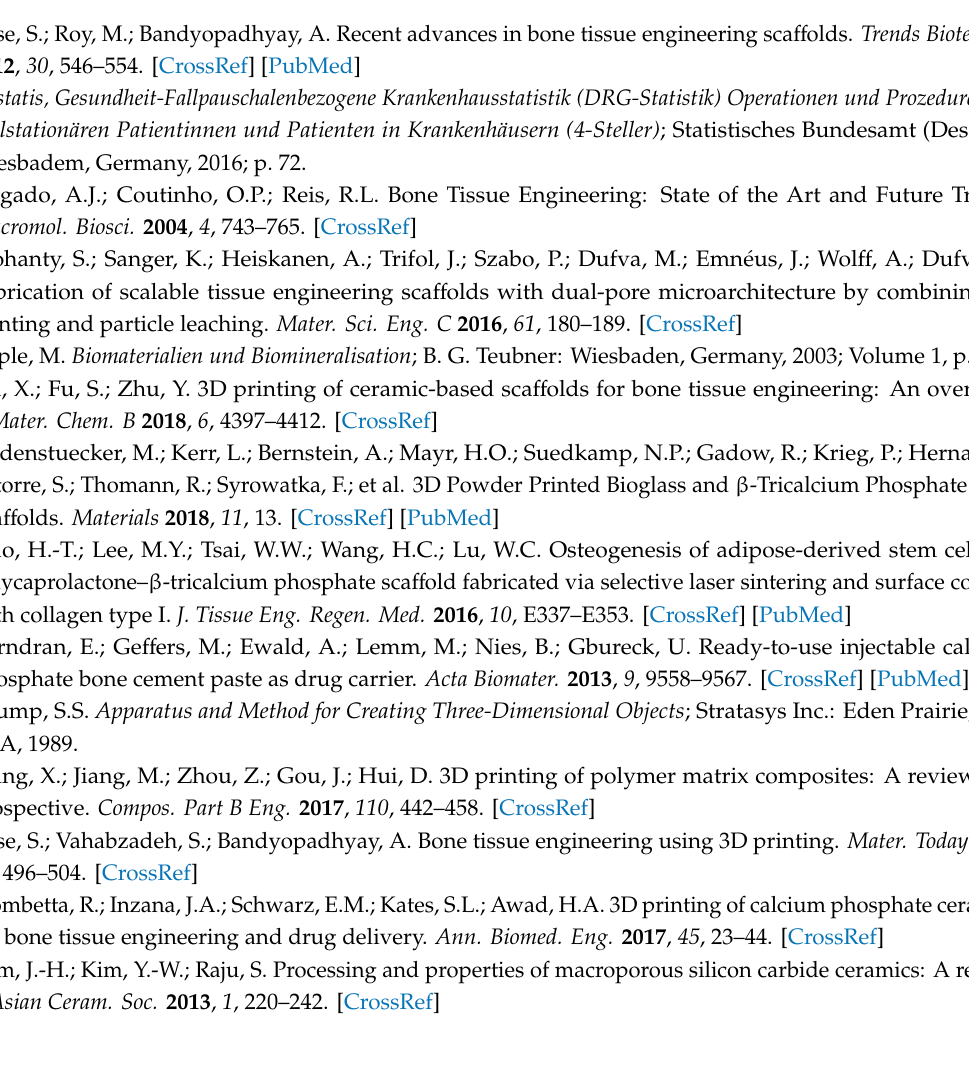
Figure S1. SBF treated samples, left = ESEM images of all three sca ff old sizes (a: 500 µ m; b:750 µ m; c: 1000 µ m) with HFW of 93.3 µ m; right = magnification of selected section with HFW of 11.7 µ m (d: 500 µ m; e: 750 µ m; f: 1000 µ m ), Figure S2: Living / Dead Cells inside the ceramics, vertical cut of 750 µ m sca ff old after three days (a: Living; d: Dead), seven days (b: Living; e: Dead), and 10 days (c: Living; f: Dead); white bar = 500 µ m, Figure